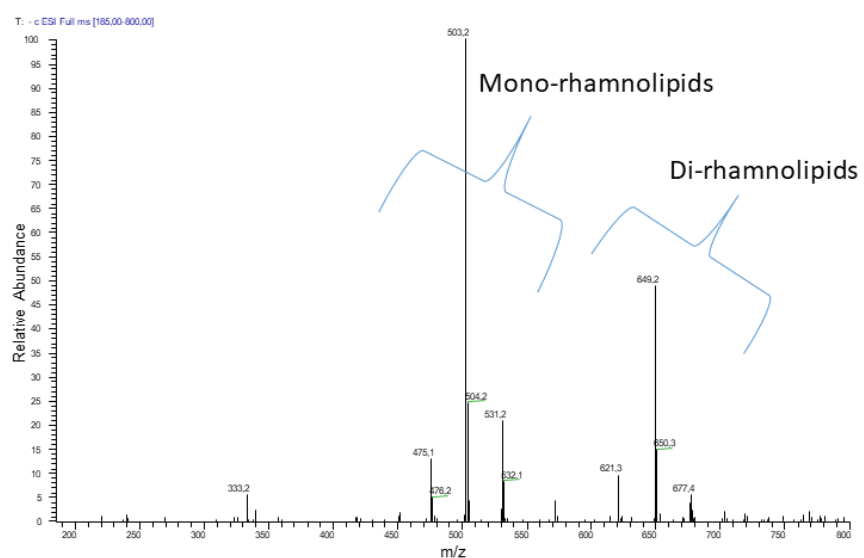
Figure 1. Negative electrospray ionization (( − )ESI) MS analysis (direct infusion) of rhamnolipids produced by Pseudomonas aeruginosa 89. Two clusters of peaks revealed two sets of homologue molecules. The first set evidenced three main signals corresponding to the [M − H] − of mono-rhamnolipids. The second set evidenced three main signals corresponding to the deprotonated molecules of di-rhamnolipids.